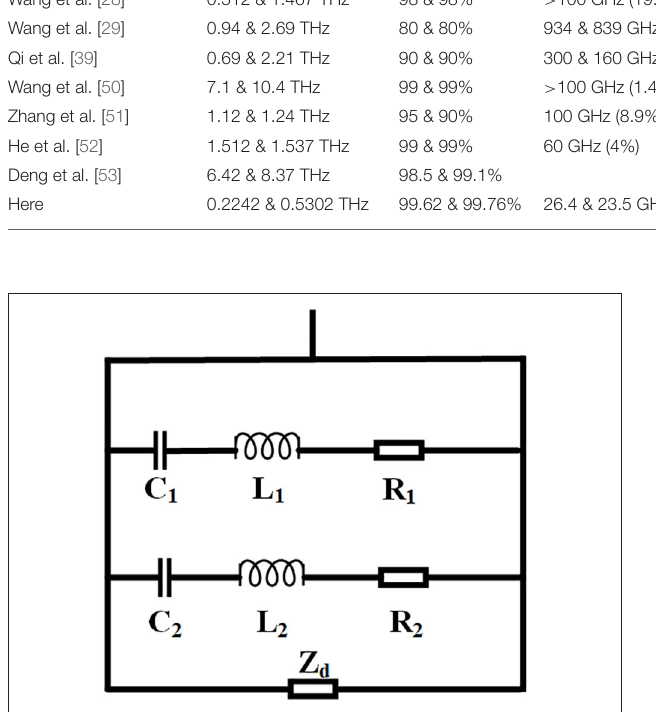
FIGURE 9 | Equivalent circuit model of designed dumbbell-shaped dual-band graphene absorber.